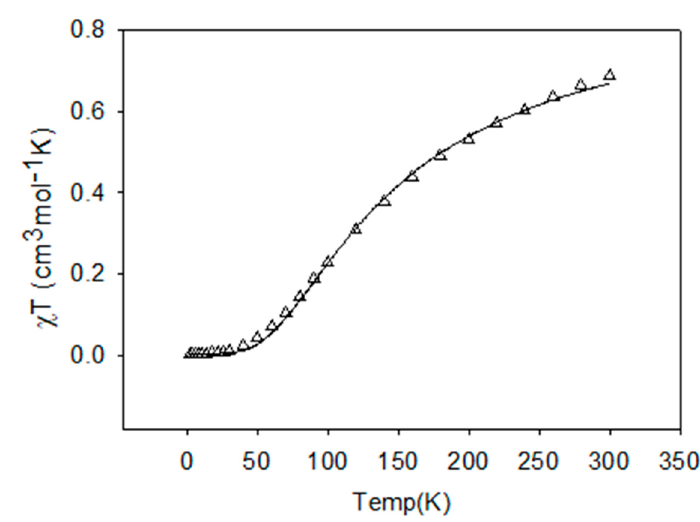
Figure 13. Plots of χ M T (triangles) vs. T per mole of [Cu 2 ] unit for 3 . The solid line is the best fit to the experimental data.